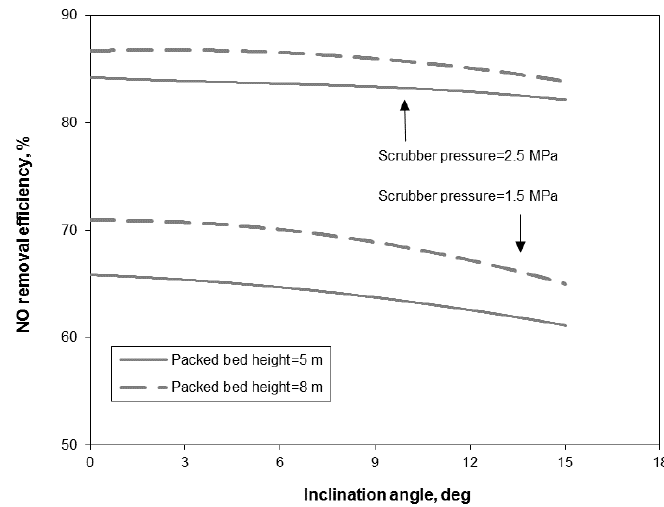
Figure 8. NO and SO 2 removal efficiency vs. seawater scrubber inclination angle (Packed-bed column with Raschig super-Rings).